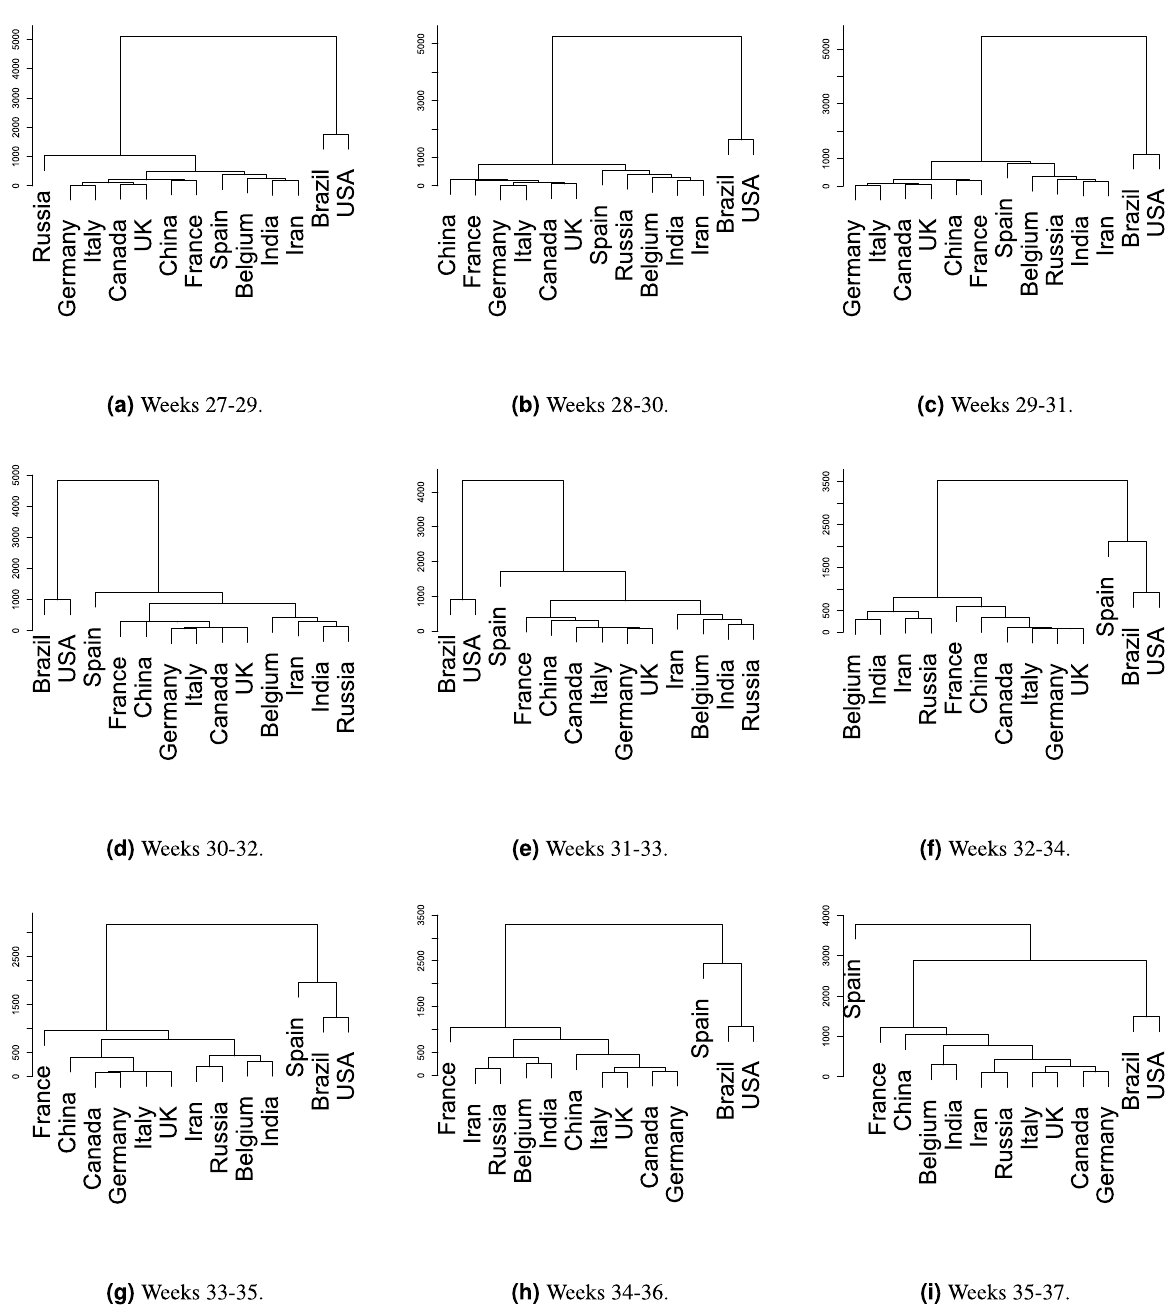
Figure 11. Spain prediction using weeks from 27 to 37 (starting counting weeks just after the first death in Brazil). The software used to cluster the time series and plot the dendrograms was the package hclust from R version